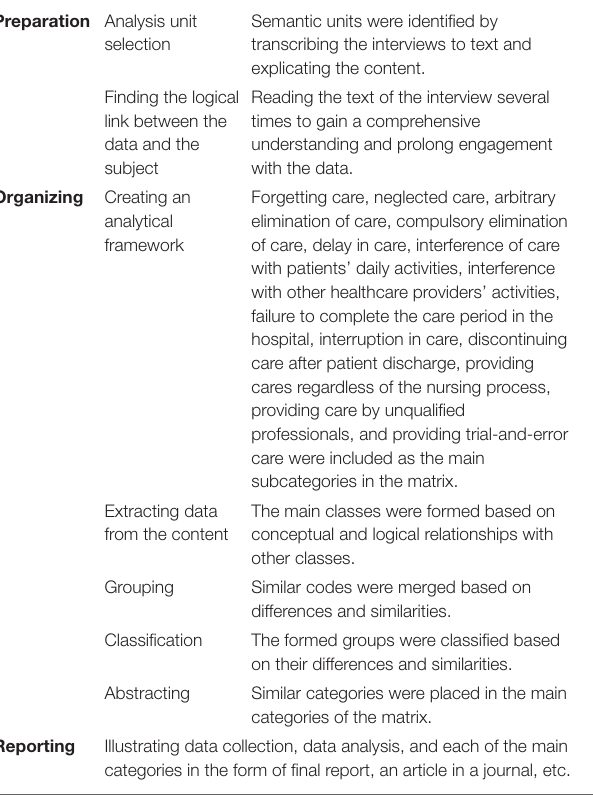
TABLE 4 | Categories and subcategories of missed nursing care types in